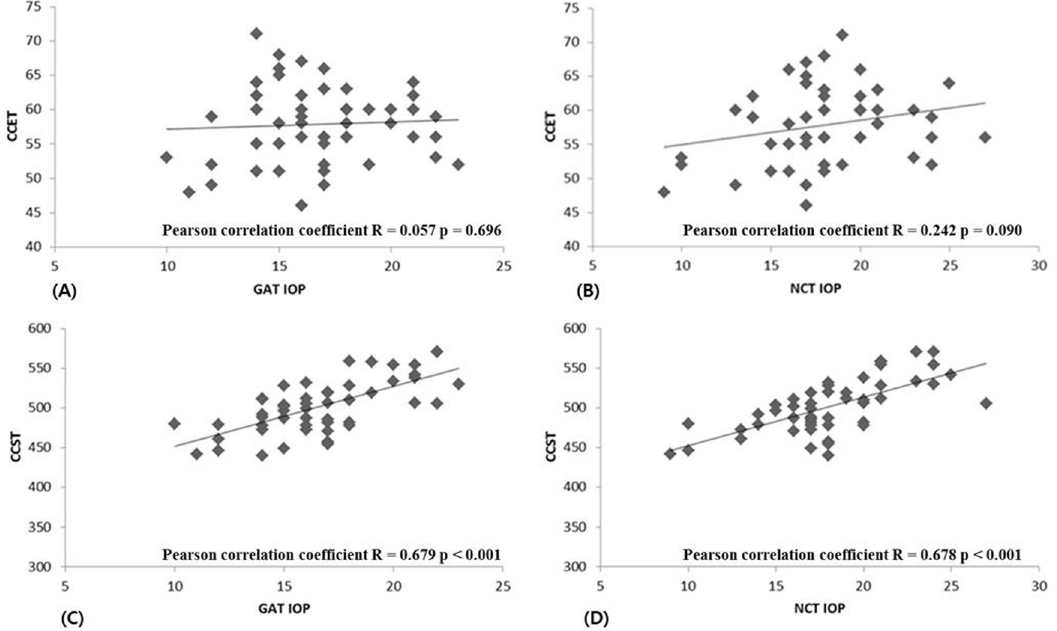
Fig 2. (A) Correlation between CCET and IOP measured by GAT. (B) Correlation between CCET and IOP measured by NCT. (C) Correlation between CCST and GAT IOP. (D) Correlation between CCST and NCT